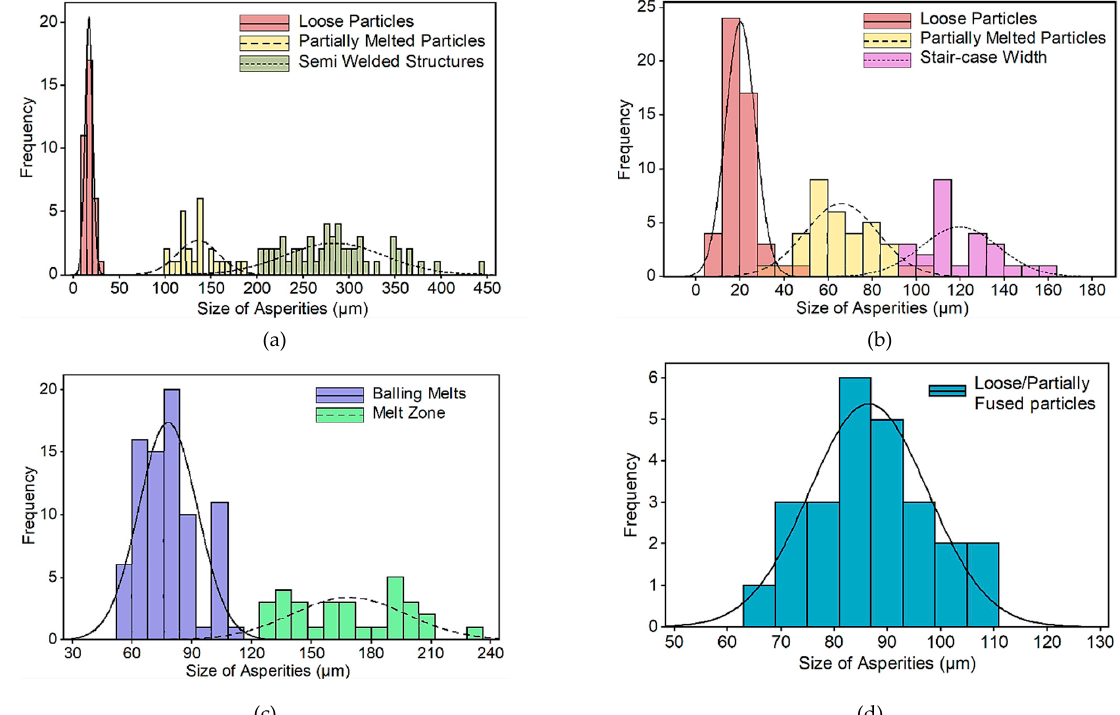
Figure 5. Particle size distribution in various AM surfaces: ( a ) SLM; ( b ) DMLS; ( c ) EBM; ( d ) LENS. Table 2. Maximum diameter of asperities in AM